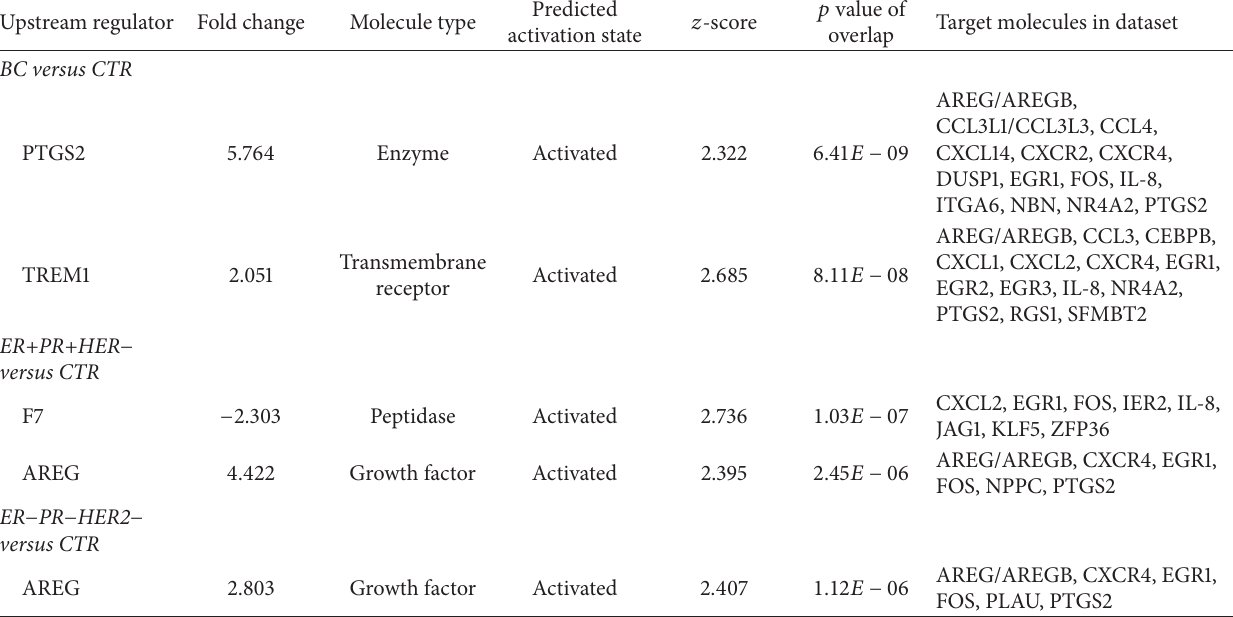
Table 3: Upstream regulators predicted by IPA in the peripheral blood cells of breast cancer patients compared with healthy donors. Upstream regulator Fold change